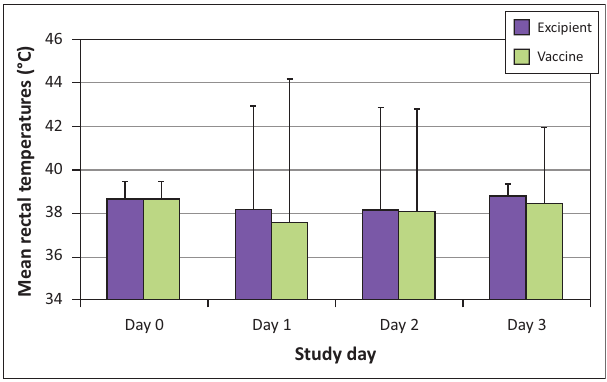
FIGURE 1: Mean and standard deviations for rectal temperature in °C from day 0 to day